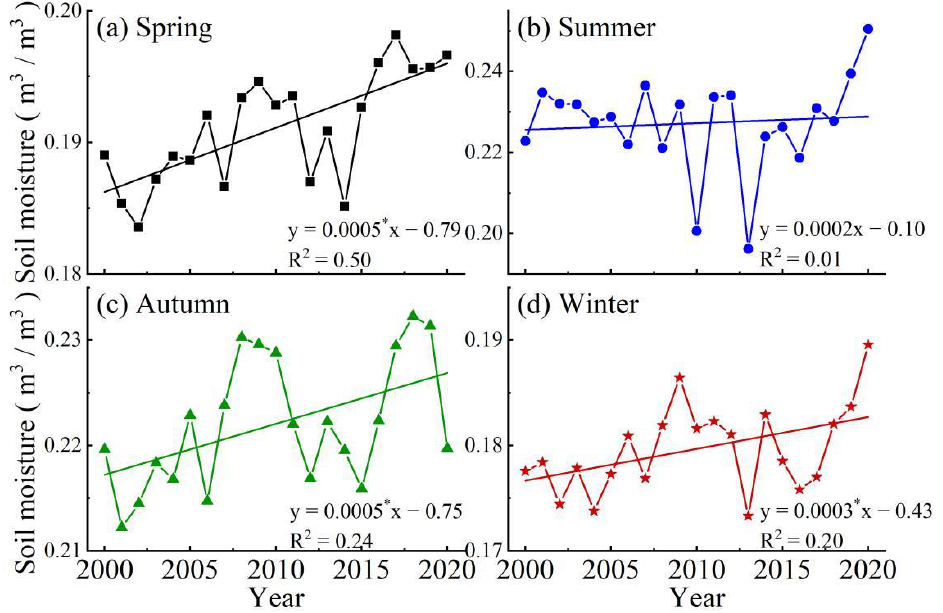
Figure 3. Changes in seasonal SM in the TP from 2000 to 2020, ( a ) spring, ( b ) summer, ( c ) autumn, and ( d ) winter, respectively. * was the significance of 0.05 level.